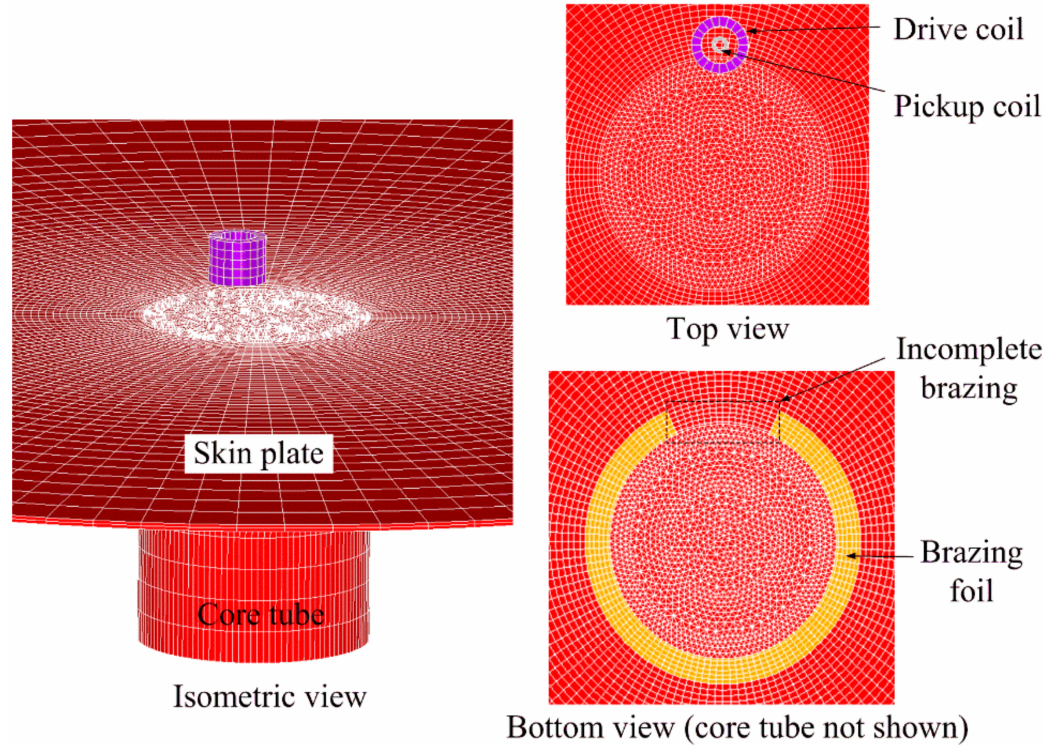
Figure 3. Finite element model of the SS core panel with an incomplete brazing